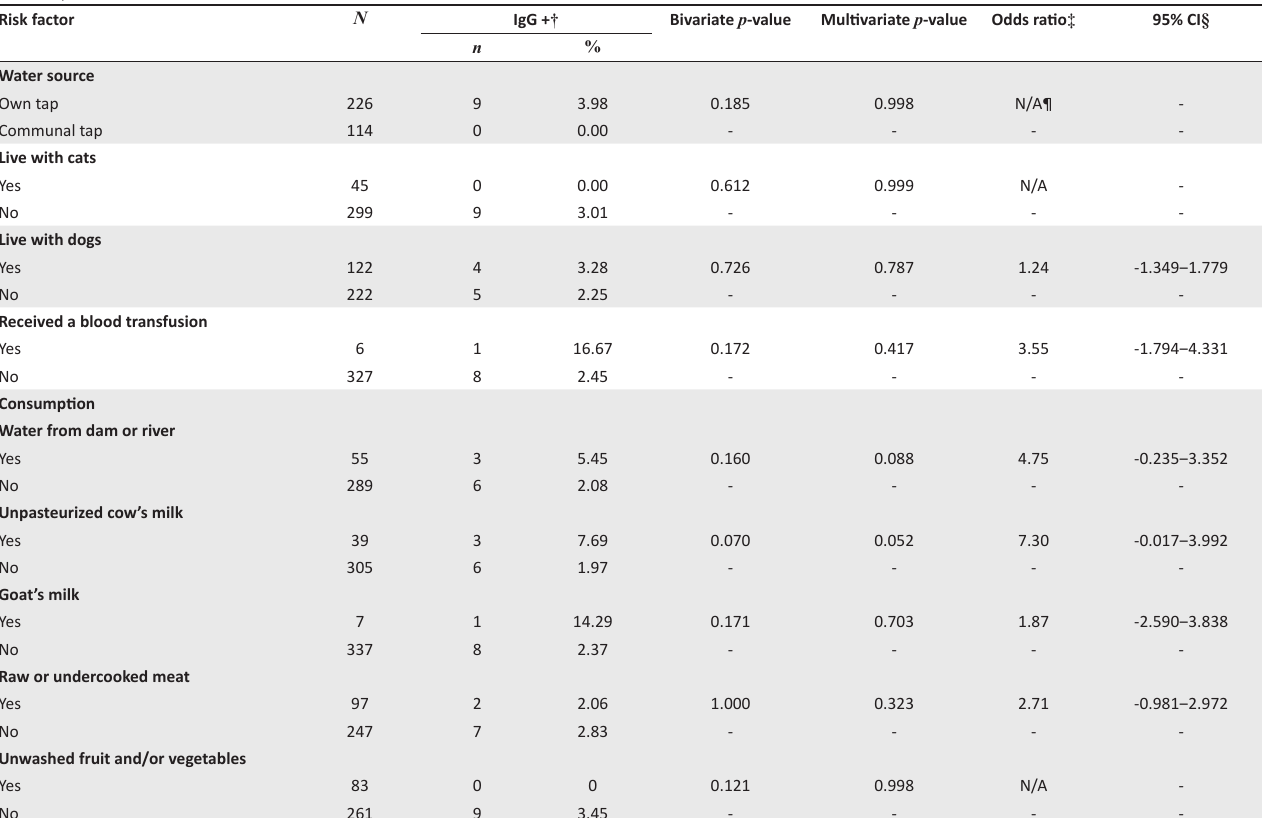
TABLE 2: Association of risk factors with seroprevalence of Toxoplasma gondii among urban pregnant women ( N = 344) attending public antenatal care in Windhoek, Namibia, 2016. Risk factor N IgG + † Bivariate p